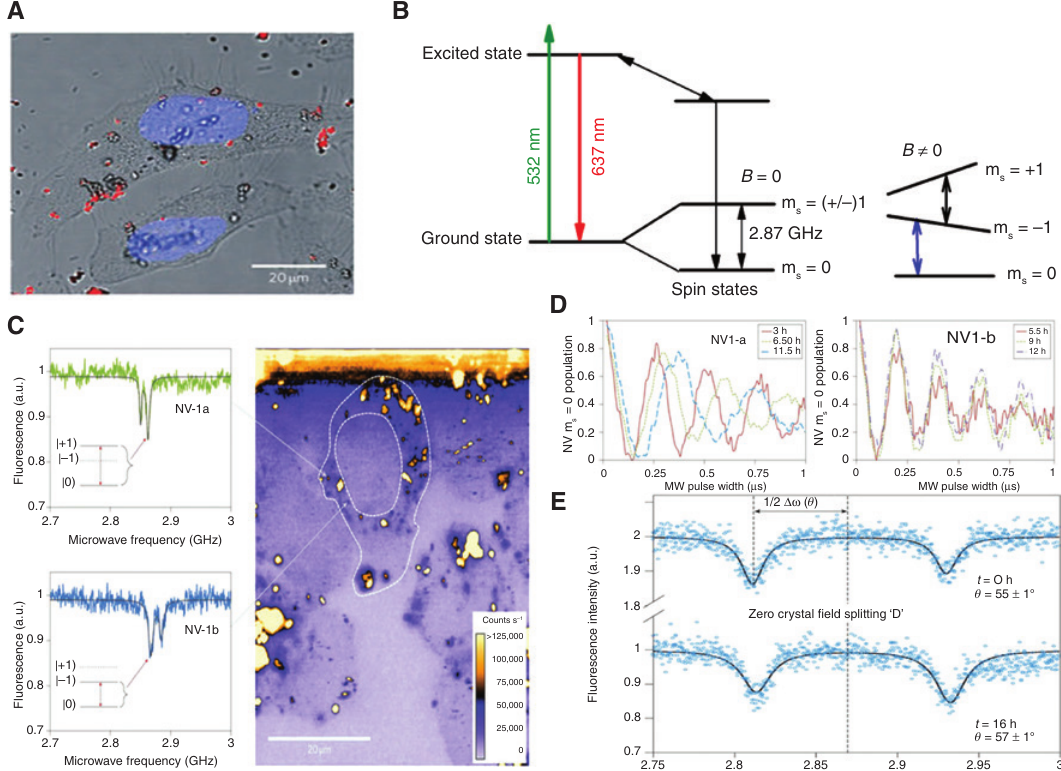
Figure 7: Tracking fluorescent nanodiamonds inside living cells process.